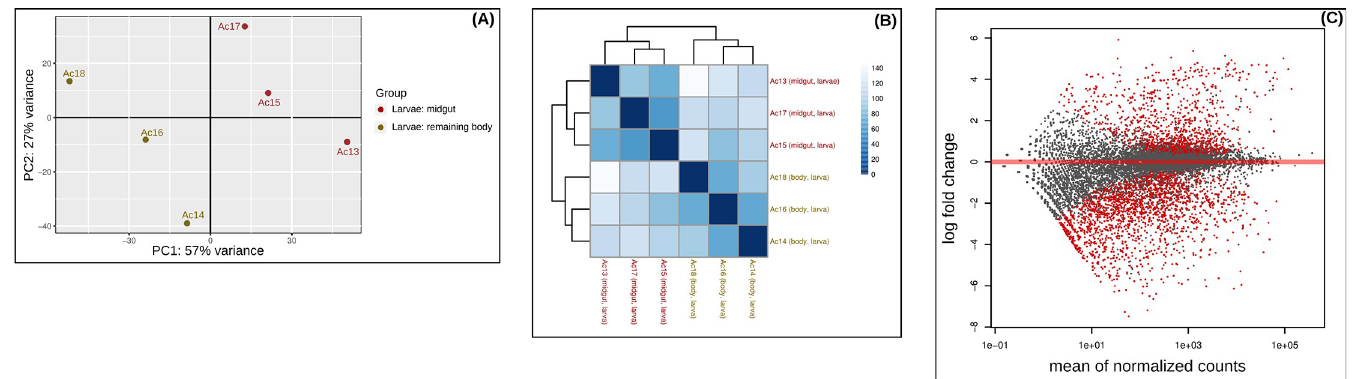
Fig 3. Principal component analysis, heatmap and MA plot. ( A ) Principal component analysis (PCA) of all genes with normalized counts. The plot shows the distribution of the six larvae transcriptome samples analyzed in the DESeq2 analysis B. The first dimension separates samples by body part i . e ., midgut vs. remaining body. ( B ) Heatmap of the sample-to-sample distances based on the normalized counts. Samples are grouped by body part (midgut vs. remaining body) as shown in the PCA plot. Color represents distance between the samples. Dark blue means shorter distance. ( C ) MA plot of the log2 fold change of all genes. Genes that passed the significance threshold (adjusted p-value < 0.1) are colored in red.